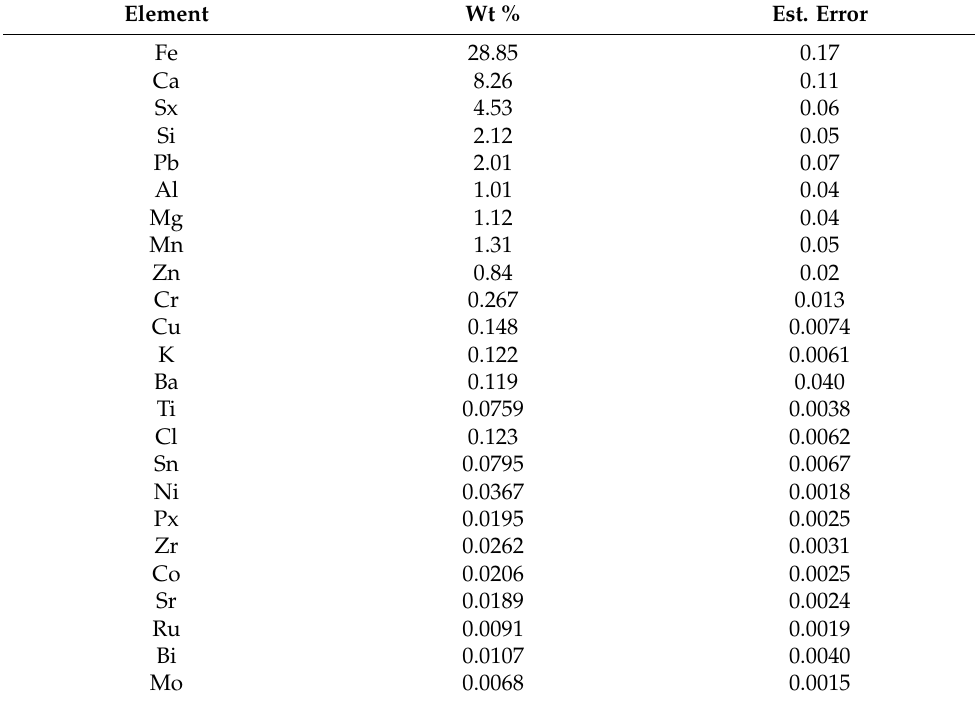
Table 5. X-ray fluorescence of leaching